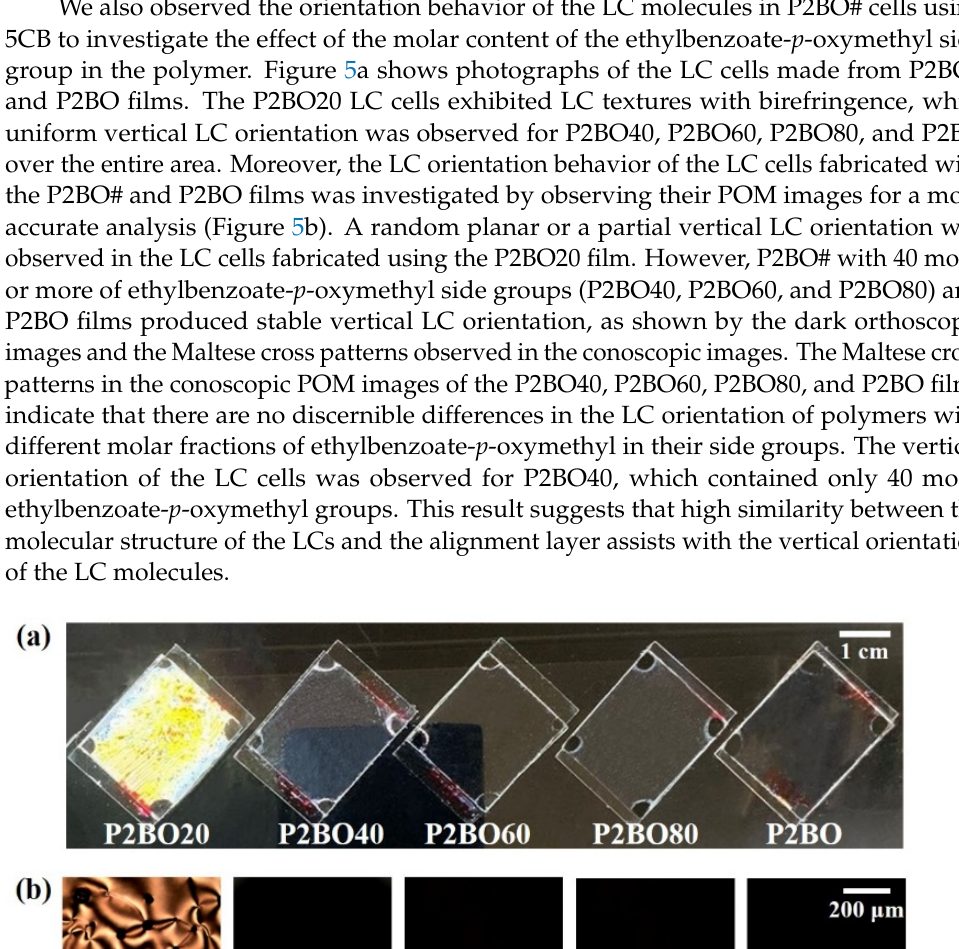
Table 2. Water contact angle and LC alignment behavior of the polymer films. Polymer Designation Water Contact Angle (°) a